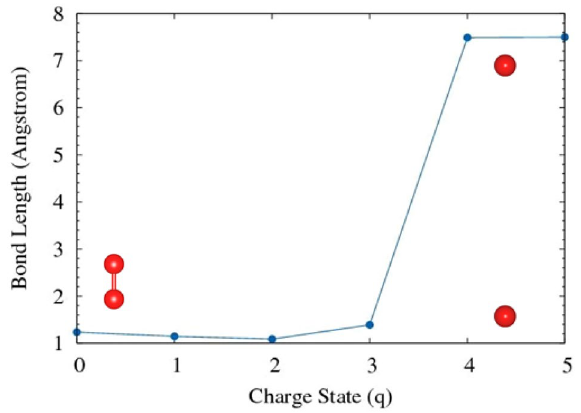
Figure 3. The effect of electron removal in oxygen molecule. The dots represents the O–O bond,the relative bond distance is indicated by O atoms.